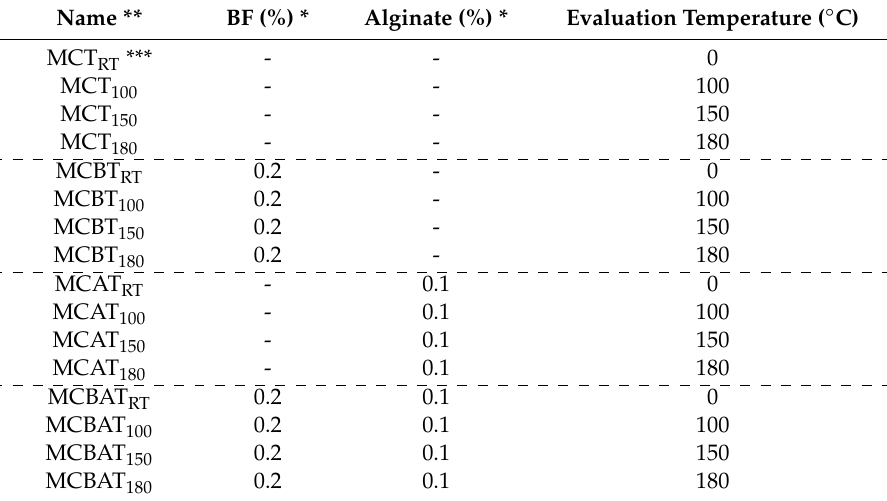
Table 5. Details of concrete composition in the main study.